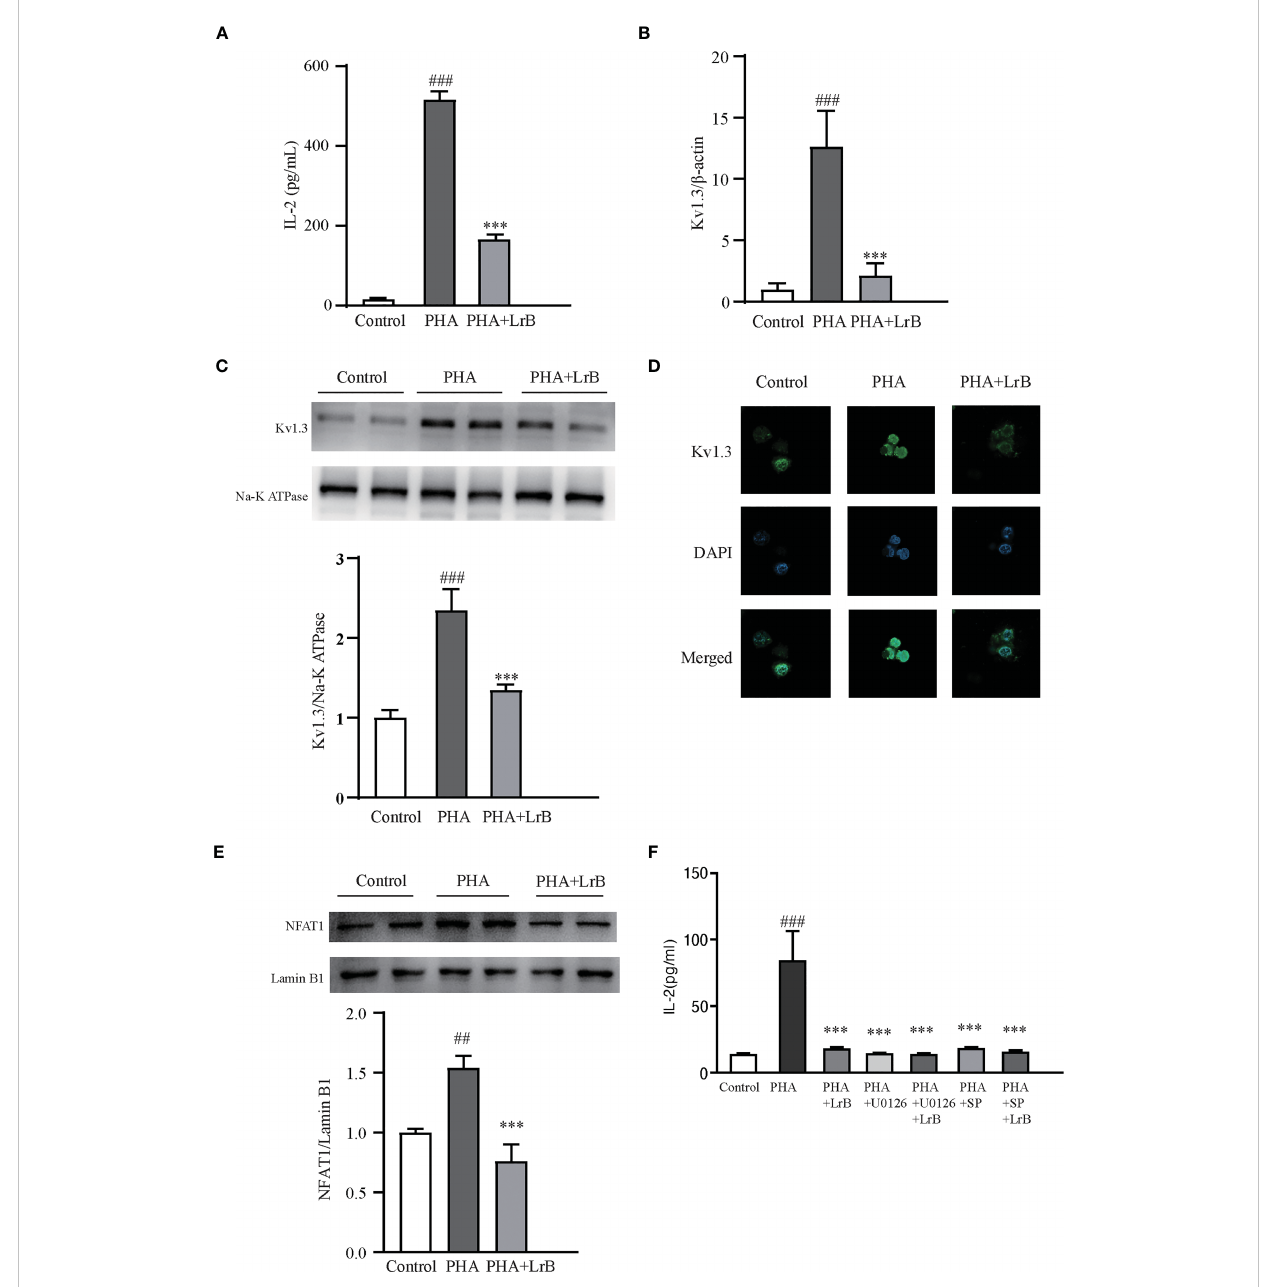
FIGURE 7 LrB decreased Kv1.3 expression and NFAT1 activation in Jurkat T cells. (A) The cytokine IL-2 released by Jurkat T cells detected by ELISA (n = 5). (B) Kv1.3 mRNA in PBMCs as shown by qPCR (n = 4). (C) Kv1.3 protein on the cell membrane was analyzed by western blot (n = 4). (D) Kv1.3 protein on the cell membrane was analyzed by immuno fl uorescence (n = 10). (E) NFAT1 in the nuclear region was analyzed by western blot (n = 6). (F) The cytokine IL-2 released by Jurkat T cells under the treatment of ERK inhibitor U0126, JNK inhibitor SP600125 and LrB (n = 3). (Results are expressed as the mean ± SEM, and tested with One Way ANOVA. ##, P ≤ 0.01, ###, P ≤ 0.001, compared to the Control group; * * * P ≤ 0.001, compared to the PHA stimulus